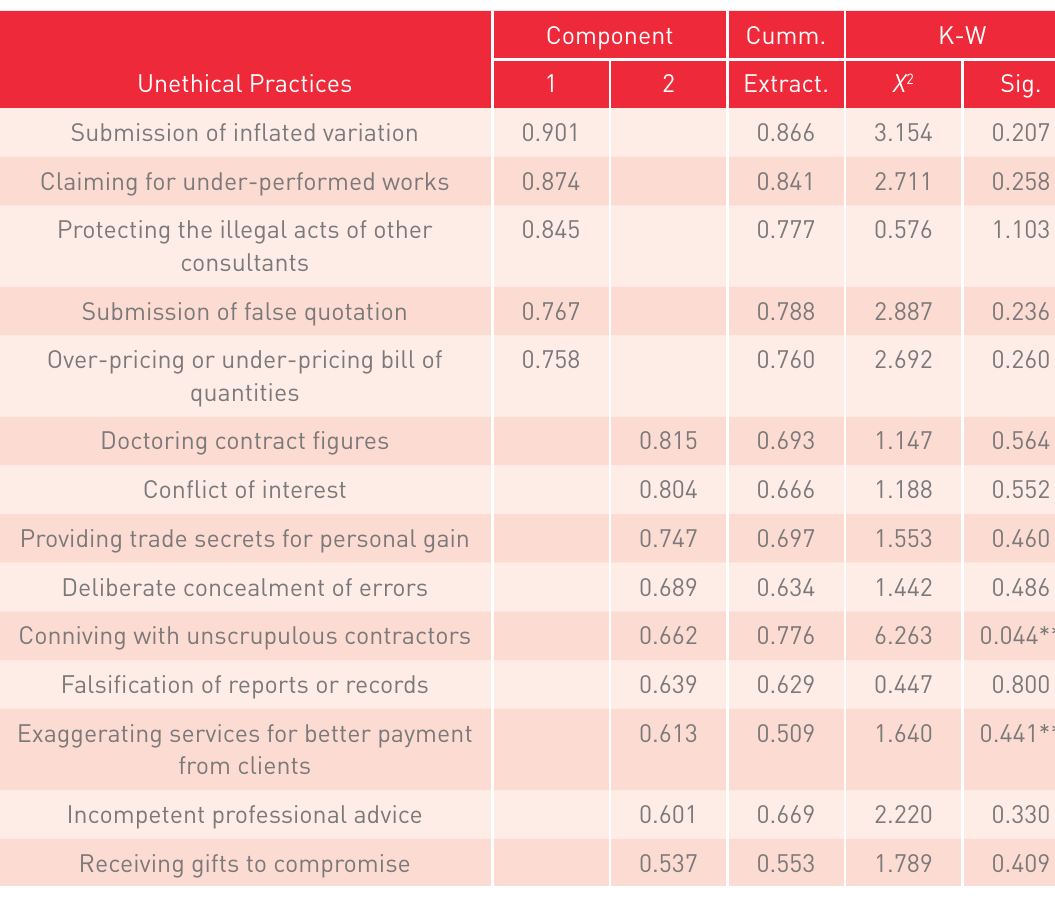
Table 4. Rotated Component